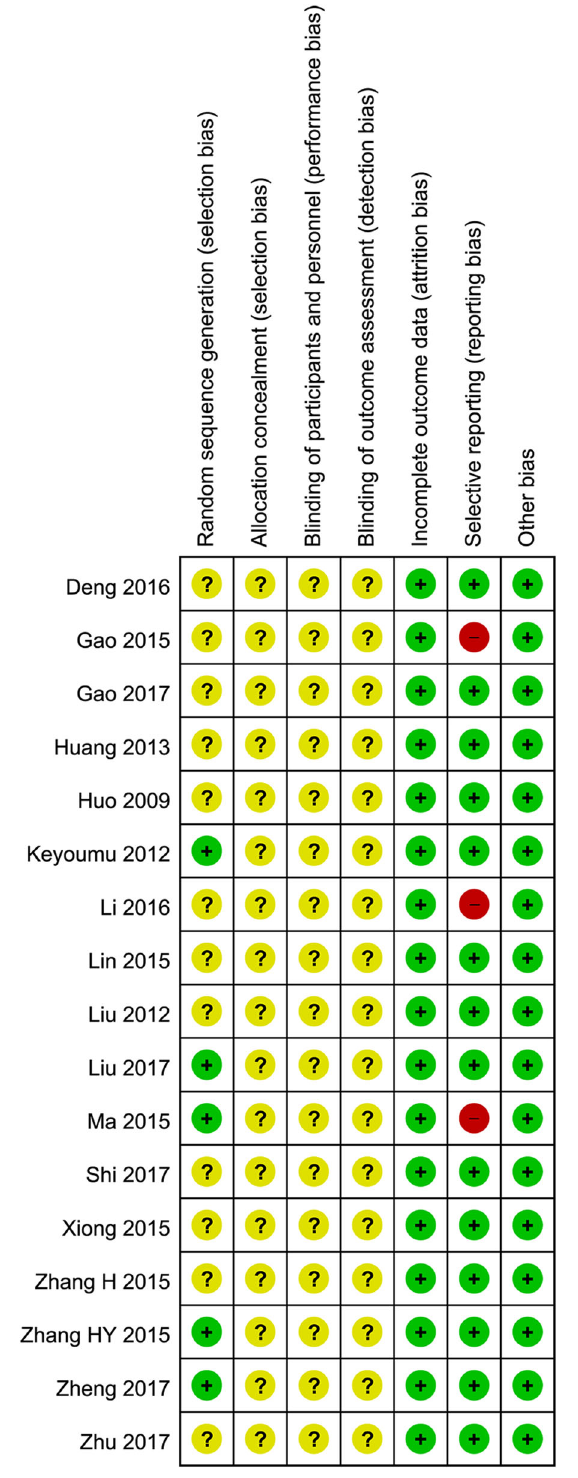
Fig. 2 Risk of bias assessment. Note: The symbols “ + ” , “ - ” , and “ ? ” indicate low, high, and unclear risk of bias,